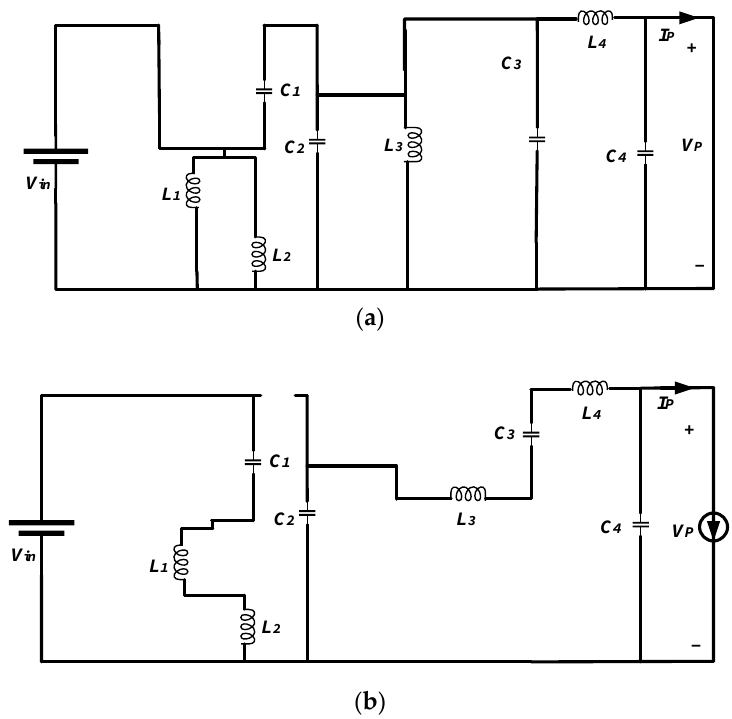
Figure 11. Equivalent circuits of the proposed inverter: ( a ) shoot-through state; ( b ) non-shoot-through state.